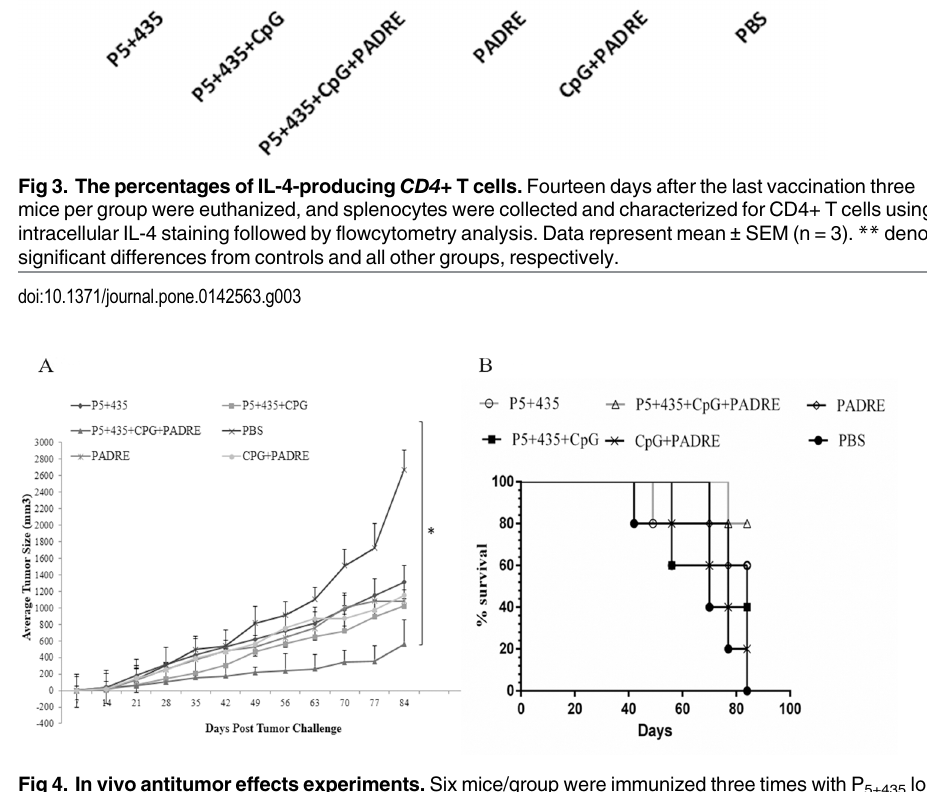
Fig 4. In vivo antitumor effects experiments. Six mice/group were immunized three times with P 5+435 long peptide alone, long peptide + CpG, or long peptide + PADRE + CpG. Control mice were immunized with PADRE, PADRE + CpG, or PBS. After 14 days the mice were challenged subcutaneously with 5× 10 5 live TUBO cells. (A) Tumors were measured weekly and sizes were recorded. The values are means of tumor size and error bars indicate SD. (B) The survival times of the mice were analyzed by log-rank (P = 0.117) and Fleming-Harrington tests (P = 0.058) for 80 days. * denotes significant difference from PBS (P <